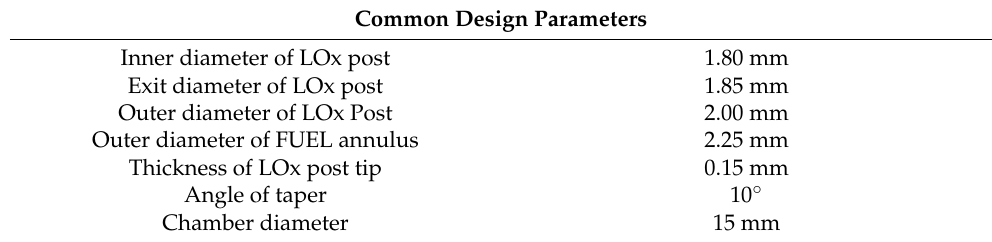
Table 8. Injector and chamber dimensions.